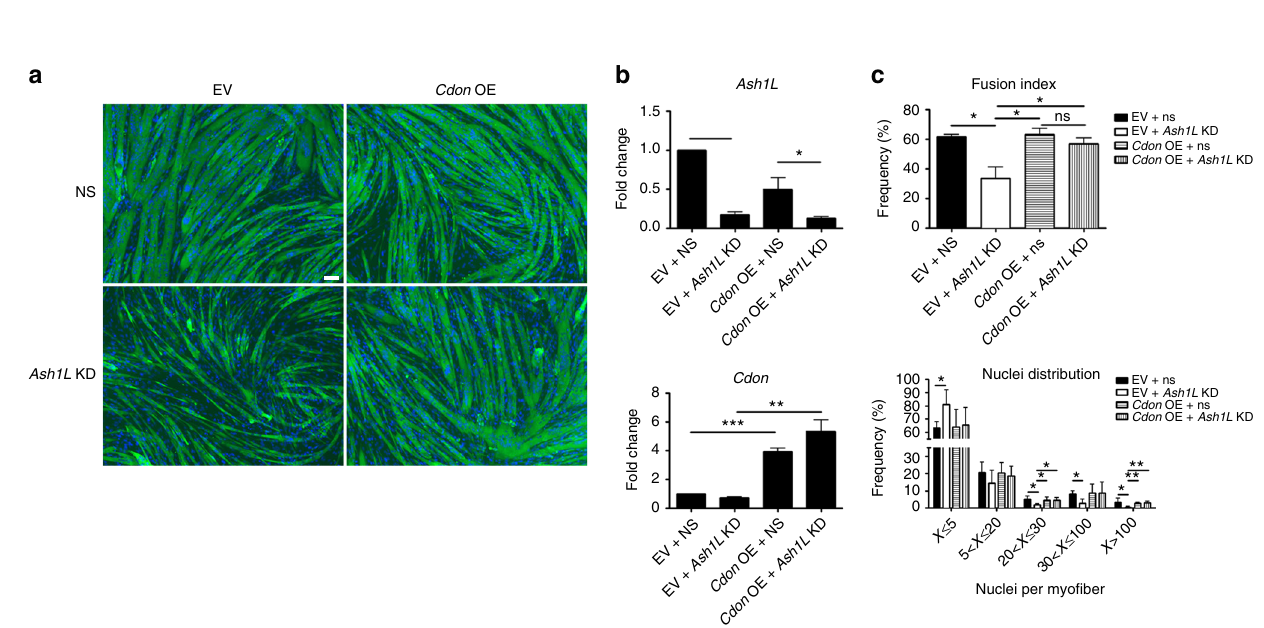
Fig. 7 The fusion gene Cdon is a direct target of Ash1L. Cdon expression positively correlates with Ash1L during muscle development ( a ) and regeneration ( b ). RT-qPCR analysis on muscle tissue from hindlimbs of mice from the embryonic stage E16.5 to adulthood and in tibialis anterior of wild-type adult mice, untreated (UNT), or 5 and 10 days after cardiotoxin (CTX) injection. Unpaired two-tailed t test. Con fi dence intervals 95%. n = 6 ( a ), n = 4 ( b ). c Cdon protein level during in vitro muscle differentiation and in proliferating myoblasts vs. con fl uent cells. Immunoblot of C2C12 cells at days 0 and 1, and densitometric analysis of Cdon signal relative to vinculin as housekeeping protein (left panel). Comparison between proliferating myoblasts (P) and con fl uent cells (C) (right panel). Paired two-tailed t test. Con fi dence intervals 95%. Data are the mean for three independent experiments. d RT-qPCR analysis comparing Cdon expression in the presence and absence of Ash1L in three different models: muscle tissue from hindlimbs of wild-type (WT) and Ash1L GT embryos at E18.5, C2C12 cells transfected with non-targeting (NS) or Ash1L siRNAs ( Ash1L KD), and human primary cells transfected with non- targeting or Ash1L siRNAs, and collected at day 1 of differentiation. Unpaired two-tailed t test. Con fi dence intervals 95%. n = 6 (muscle tissue), four independent experiments (C2C12 cells), and three independent healthy subjects (human samples). e Western blotting analysis showing Cdon downregulation in muscle tissue from hindlimbs of Ash1L GT embryos at E18.5 compared to wild type (WT), and in C2C12 cells transfected with Ash1L siRNAs ( Ash1L KD) compared to control (NS). Densitometric analysis of both Ash1L and Cdon signals relative to vinculin as housekeeping protein are reported on the right. Paired one-tailed t test. Con fi dence intervals 95%. n = 3 (muscle tissue), three independent experiments (C2C12 cells). f Ash1L speci fi cally binds to Cdon genomic region. Genome browser representation of Ash1L ChIP-seq peaks (from three replicates), at Cdon genomic region. Relative positions of both positive and negative regions are shown at the bottom (left). Chromatin immunoprecipitation on C2C12 cells transfected with non-targeting (NS) or Ash1L siRNAs ( Ash1L KD), and fi xed at day 1 of differentiation, using Ash1L antibody and IgG as a negative control. qPCR analysis on positive and negative regions according to ChIP-sequencing results (right). Unpaired two-tailed t test. Con fi dence interval 95%. n = 3. Source data are provided as a Source Data fi le. * p ≤ 0.05, ** p ≤ 0.01, *** p ≤ 0.001